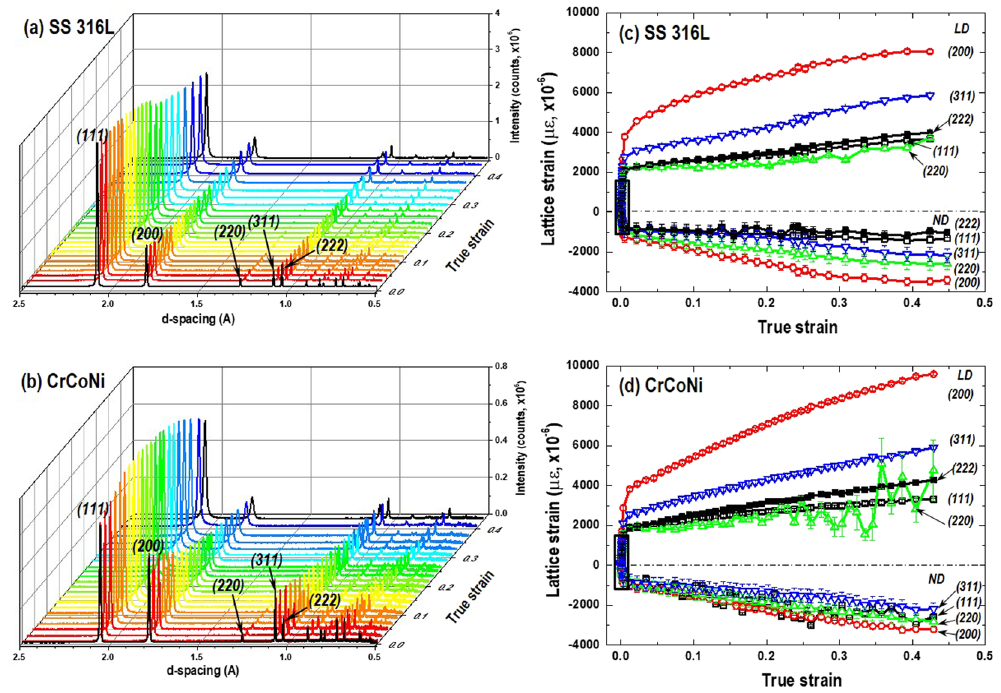
Figure 4. Diffraction peak patterns as a function of true strain collected at ( a ) AM SS 316 L and ( b ) AM CrCoNi specimens. Obtained by the axial detector where the scattering vector (Q) is paralleled to the longitudinal direction (LD). The evolution of lattice strains along the LD and normal direction (ND) measured from grain families of {111}, {200}, {220}, {311}, and {222} crystallographic planes during loading in ( c ) AM SS 316 L and ( d ) AM CrCoNi